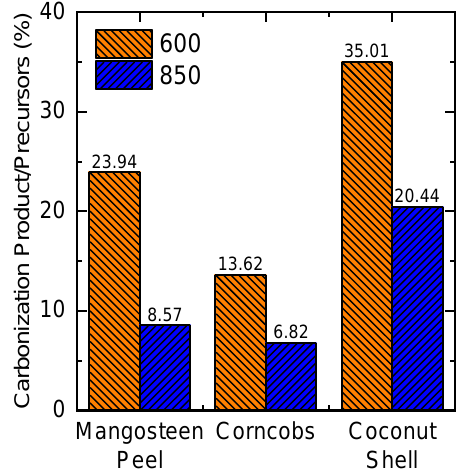
Figure 3. Percentage of product / precursor at carbonization temperatures 600 ◦ C and 850 ◦ C. Data of carbonization yield of mangosteen peel taken from our previous study [18].